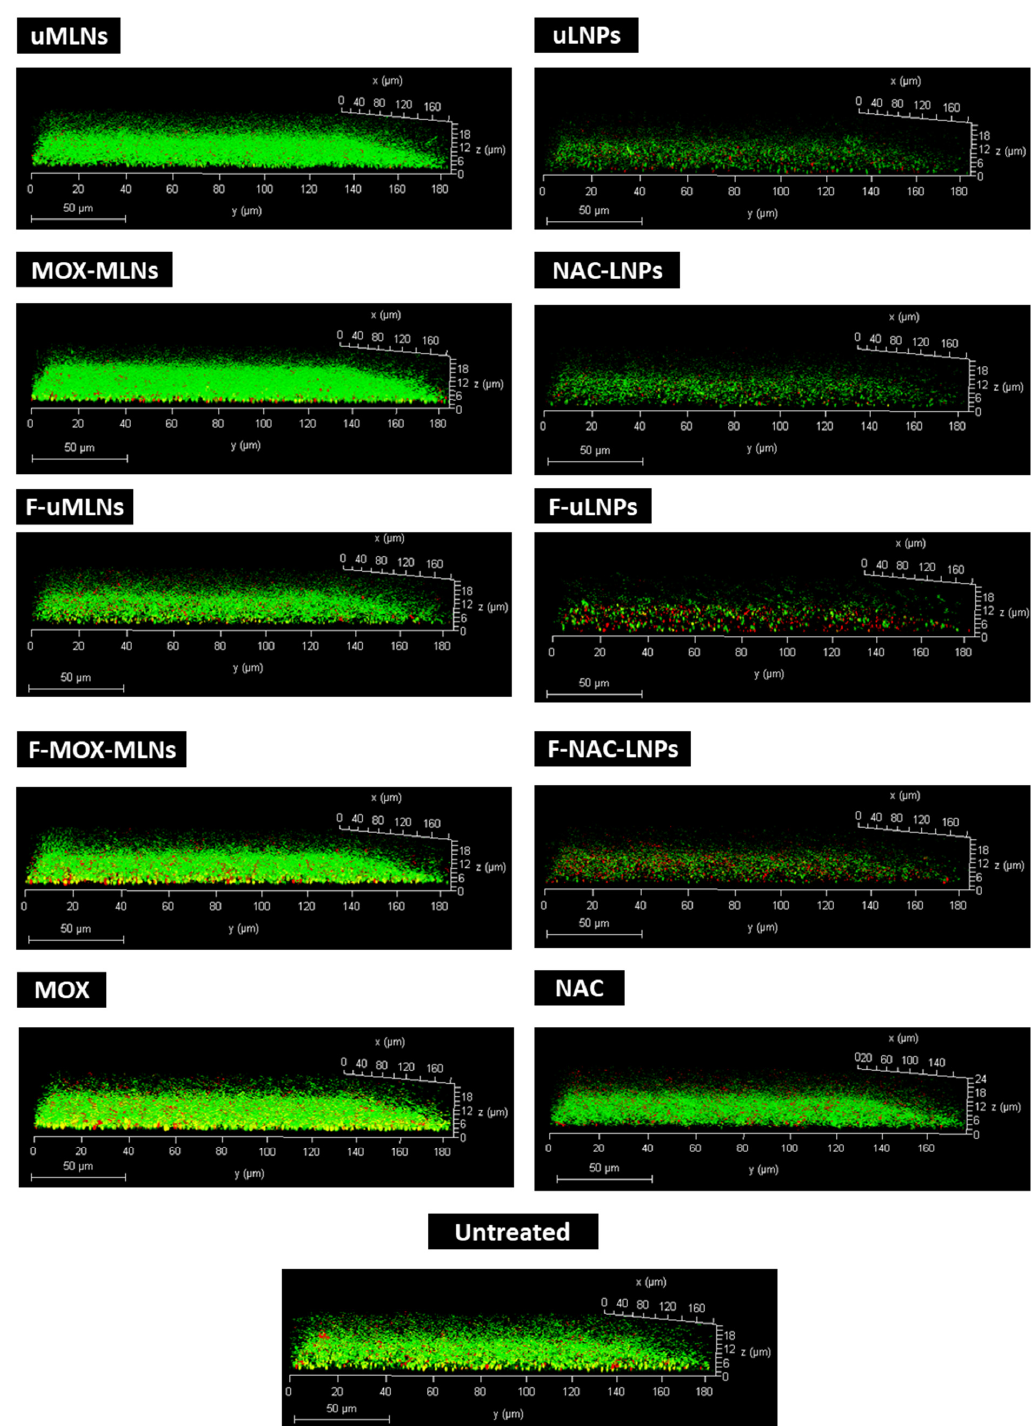
Figure 6. Three-dimensional CLSM images of untreated (control) and treated Xen36 biofilms. The developed MLNs and free MOX were tested at a MOX concentration of 0.5 µ g mL − 1 . For the biofilms treated with unloaded and NAC-loaded LNPs, a solid lipid concentration of 2 mg mL − 1 (0.9 mg mL − 1 of NAC) was used. Free NAC was used at the same concentration. The biofilms were stained with the LIVE/DEATH kit, where viable and dead cells are visualized in green and red, respectively. Untreated biofilms were used as a positive control. Scale bar, 50 µ